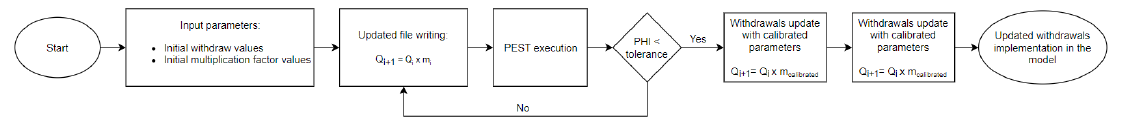
Figure 4. Flow chart of WMG